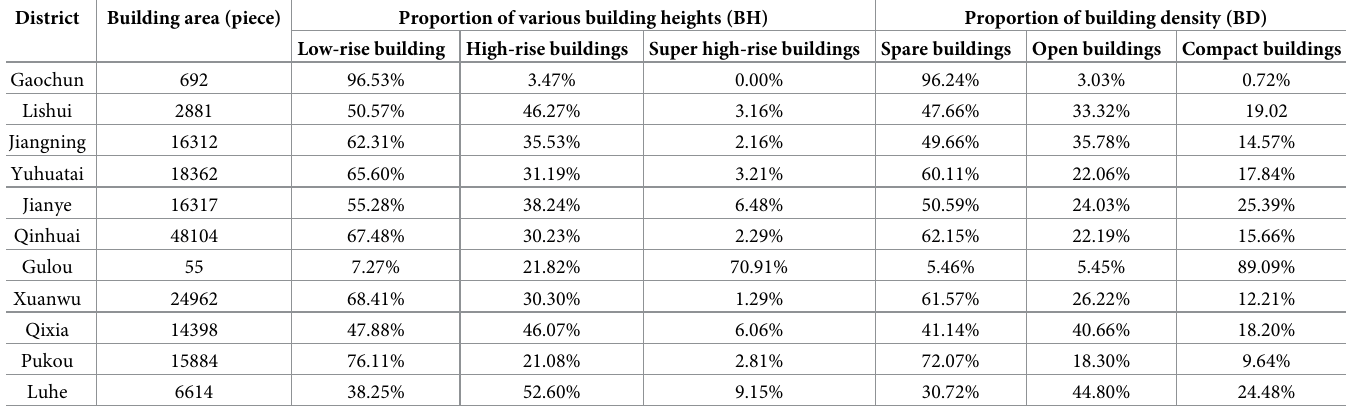
Table 4. Statistics of buildings in each